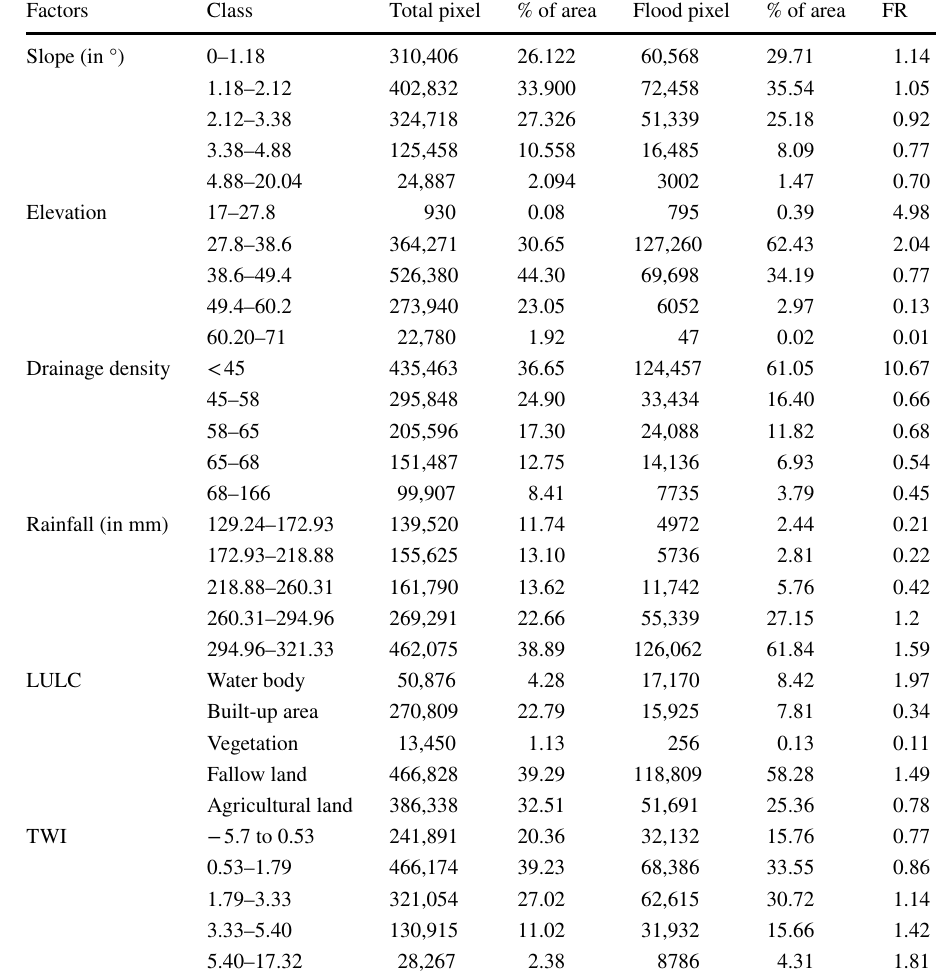
Table 2 Rating of parameters used for vulnerability mapping through FR model